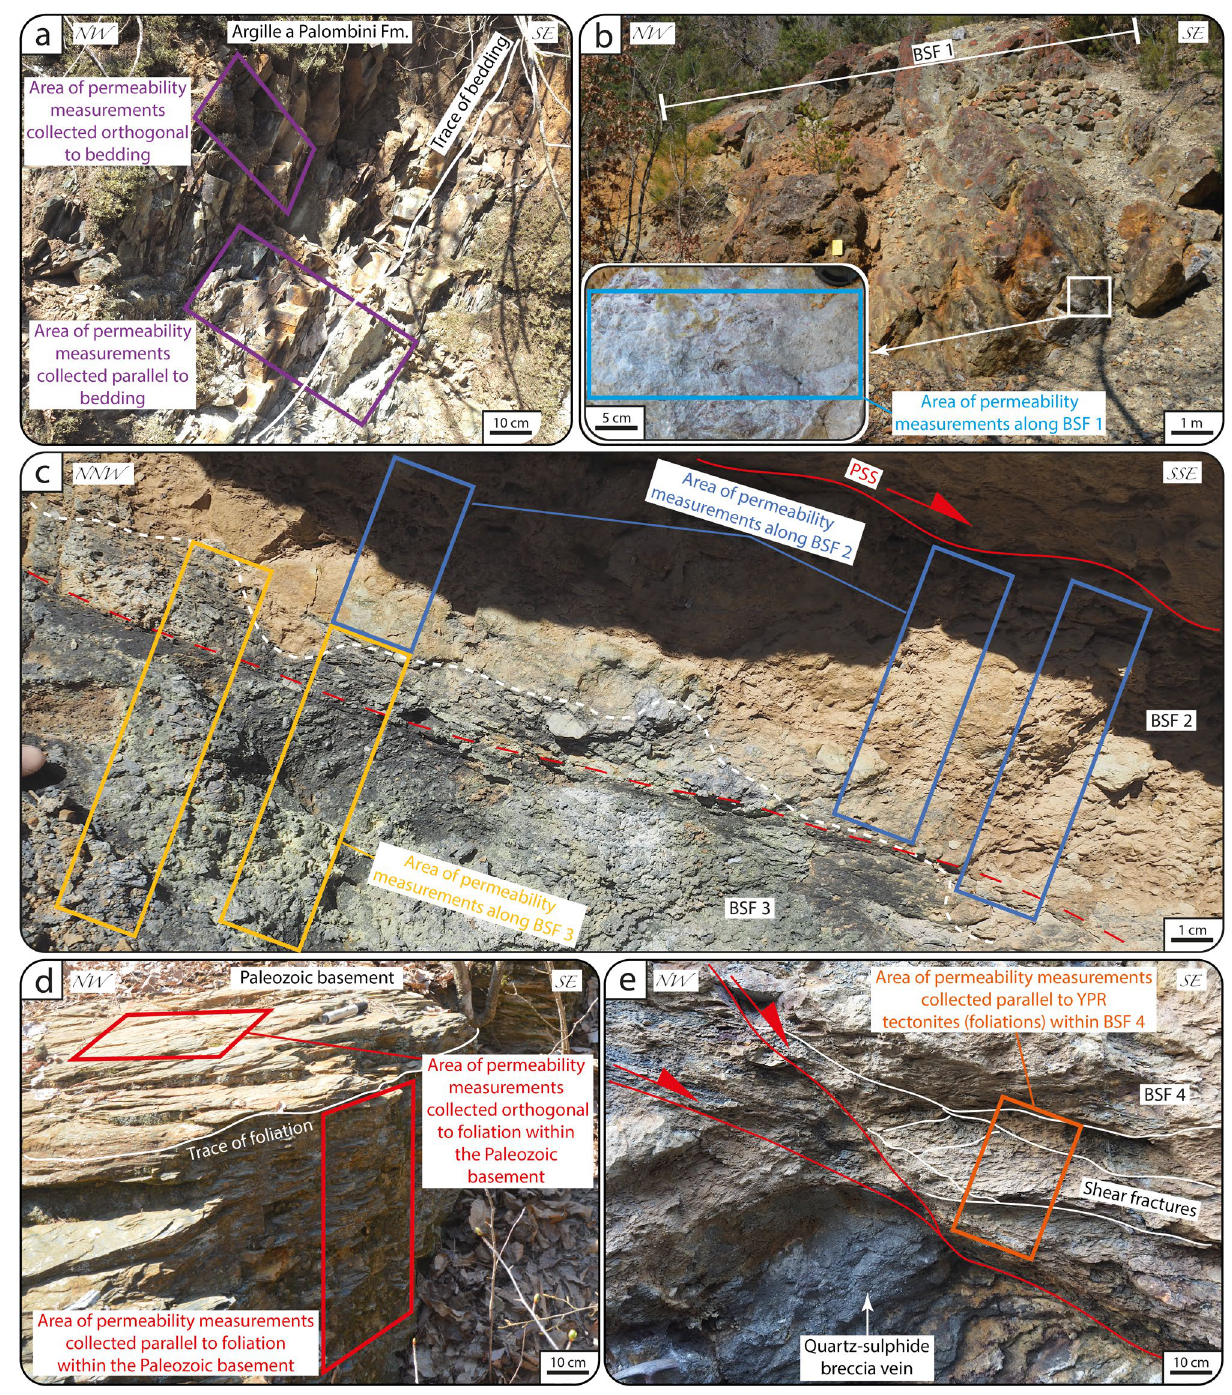
Figure 7. Stations of permeability measurements along the BF. ( a ) Shales belonging to the hanging wall unit (Argille a Palombini Fm.). ( b ) BSF1. ( c ) BSF2 (below the PSS) and BSF3. Note that the (irregular) boundary between BSF2 and BSF3 (white dotted line) is cut by a later secondary slip surface (red dotted line). ( d ) Micaschist of the footwall unit (Paleozoic basement). ( e ) BSF4 characterized by shear